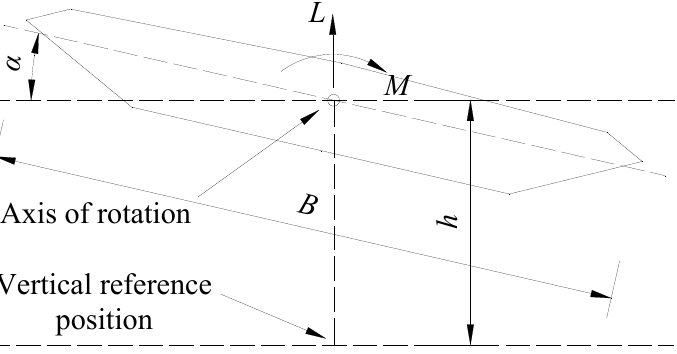
Figure 5. Aerodynamic forces and displacements of the girder section model.